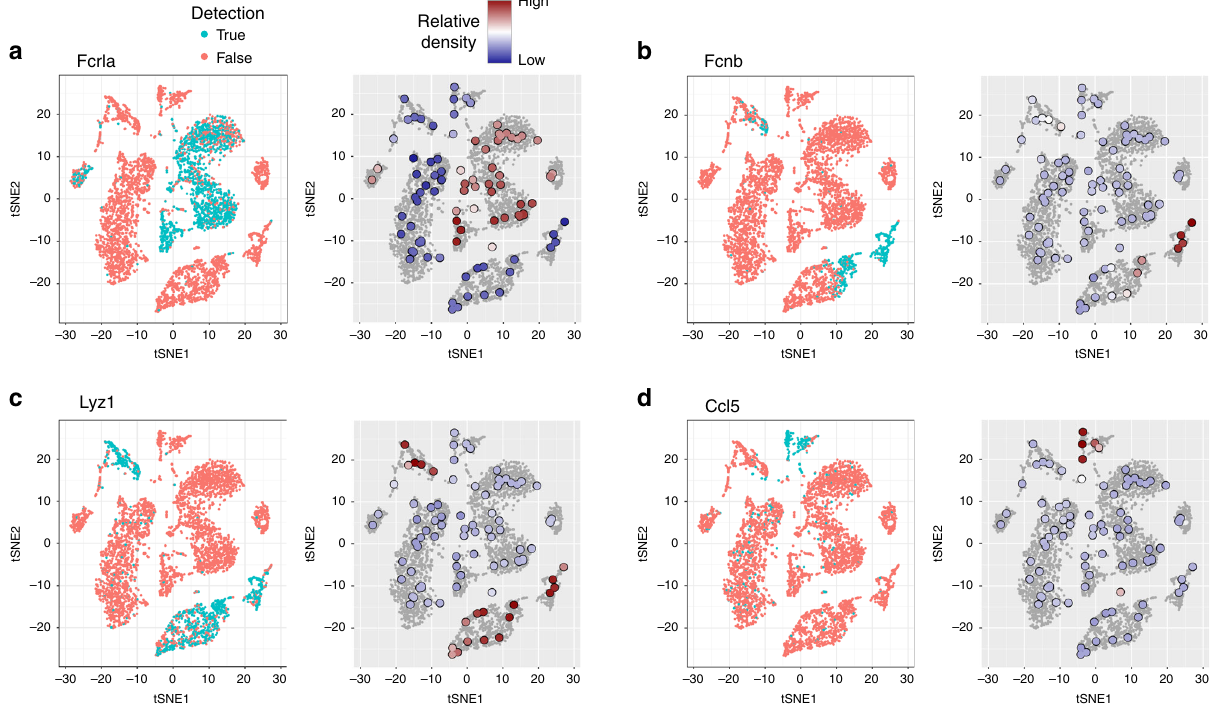
Fig. 1 Illustration of the expression distribution approach for DEG prediction. a – d For four example genes in the Tabula Muris bone marrow tissue dataset, t-SNE plots are shown, with the detection of the gene (left) and the expression distribution of the gene (right). In the expression distribution plots, colored circles represent the 100 grid points decided by singleCellHaystack, their color re fl ecting P ( G = T )/ Q . t-SNE coordinates of grid points are approximate: grid points were projected to the t-SNE coordinates of their most proximal cell in the 50 PC space.